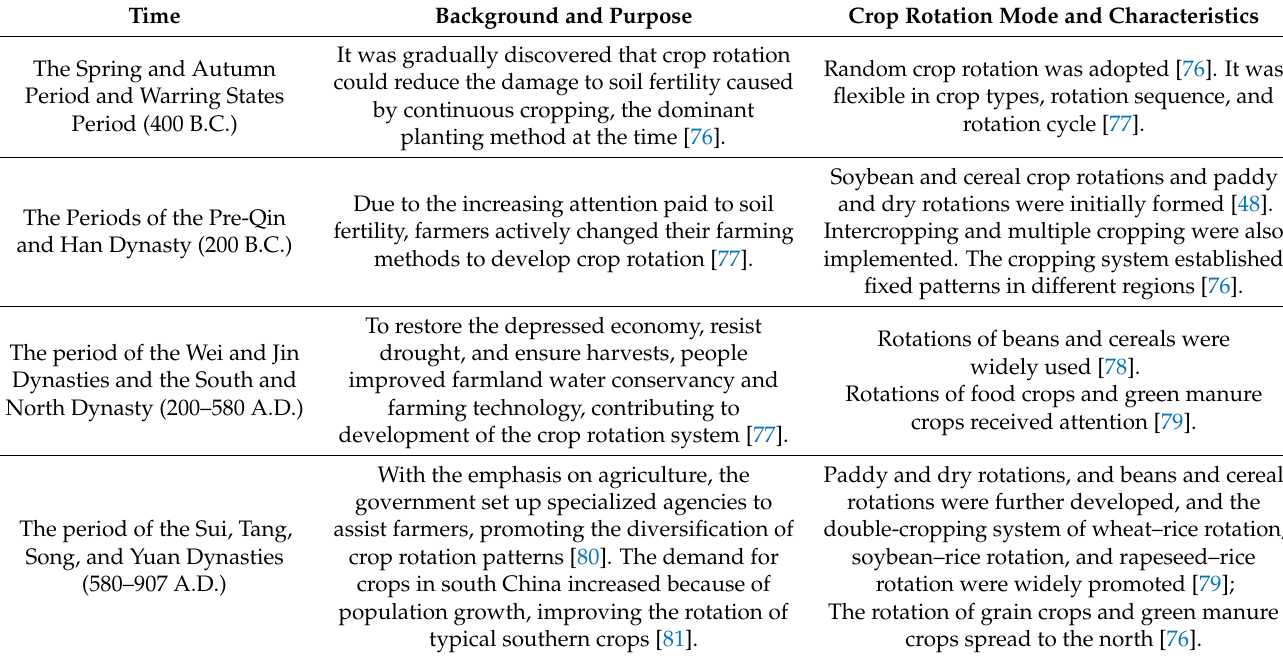
Table 2. The development of crop rotation in